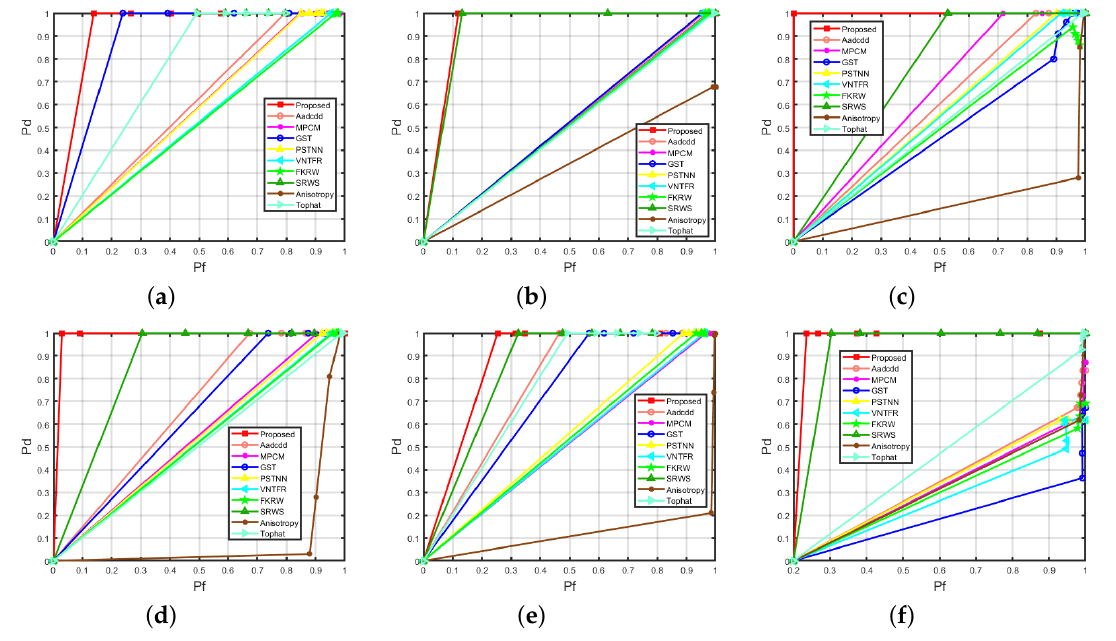
Figure 15. ( a – f ) represents the ROC curves for the ten algorithms under six